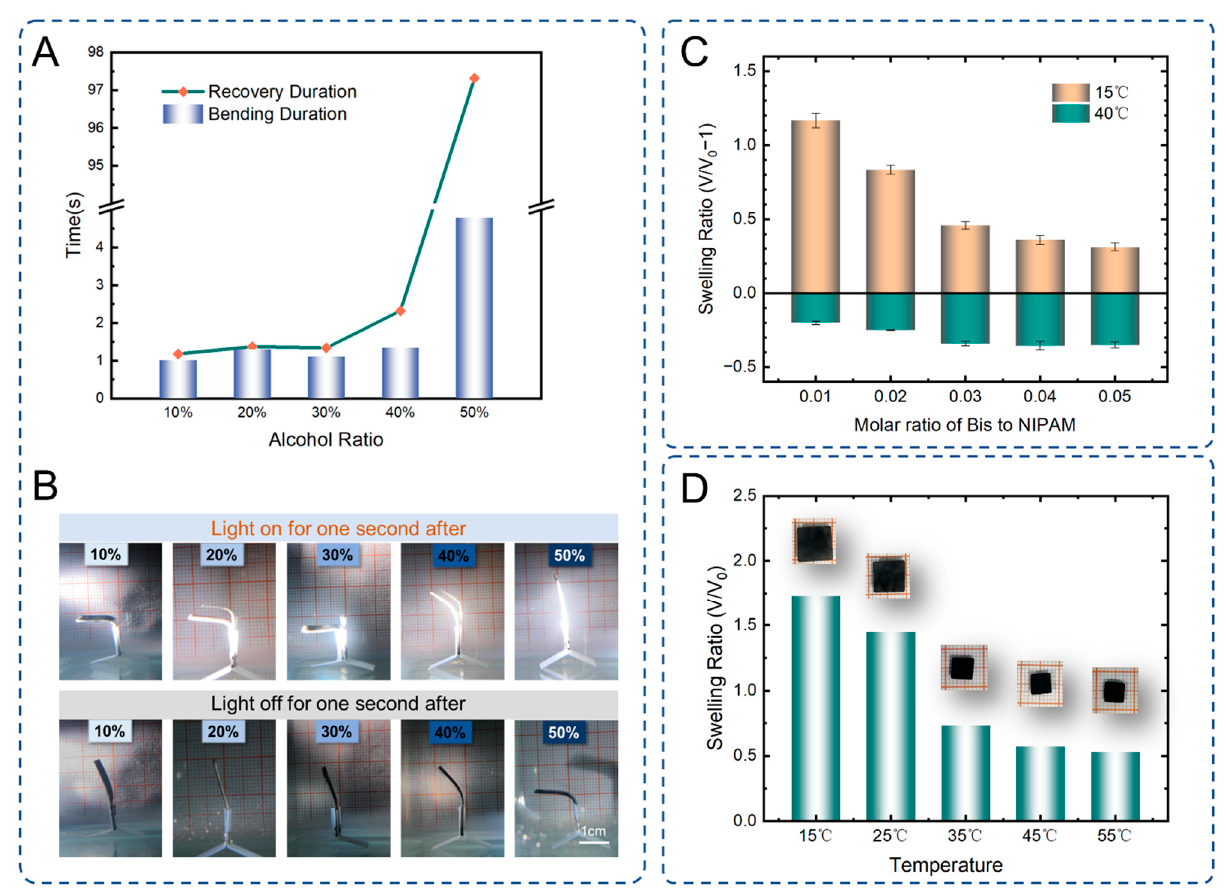
Figure 3. ( A ) The effect of different concentrations of alcohol as solute on the deformation properties of hydrogels. ( B ) Comparison of bending deformation and recovery states of hydrogel samples with different concentrations of alcohol as solute after one second of light exposure and one second of light off. ( C ) The effect of molar ratio of crosslinker to monomer on the swelling rate of hydrogels. ( D ) Effect of the concentration of NIPAM on the swelling rate of hydrogels.